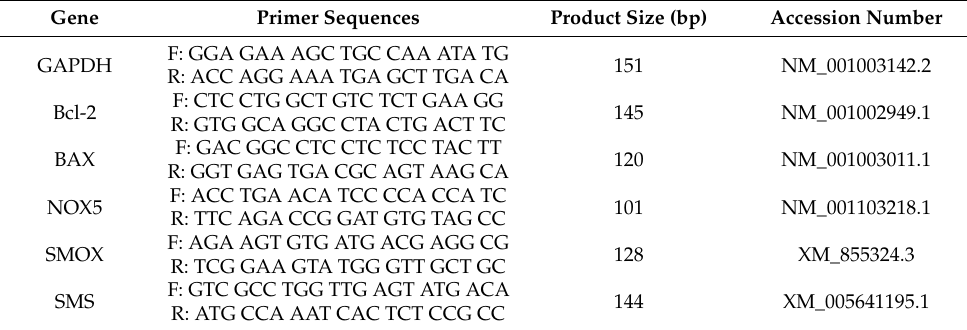
Table 1. Primers sequences used for the analysis of relative gene